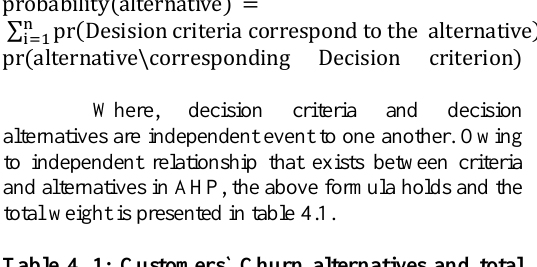
Table 4. 1: Customers` Churn alternatives and